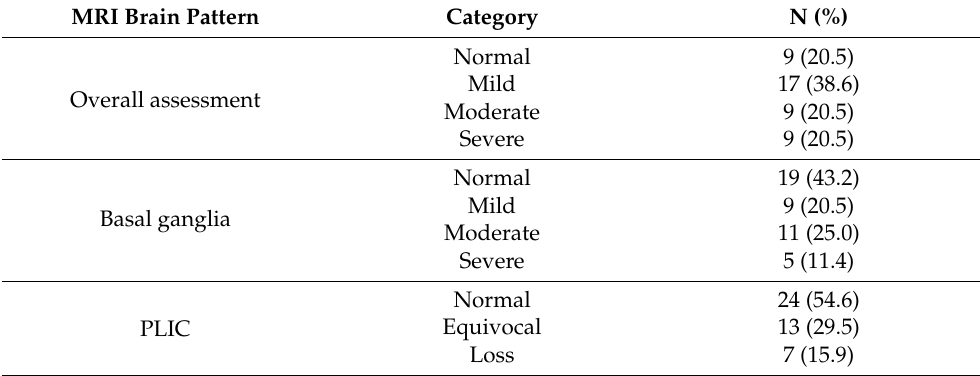
Table 2. MRI brain patterns and the levels of injury according to Rutherford classification